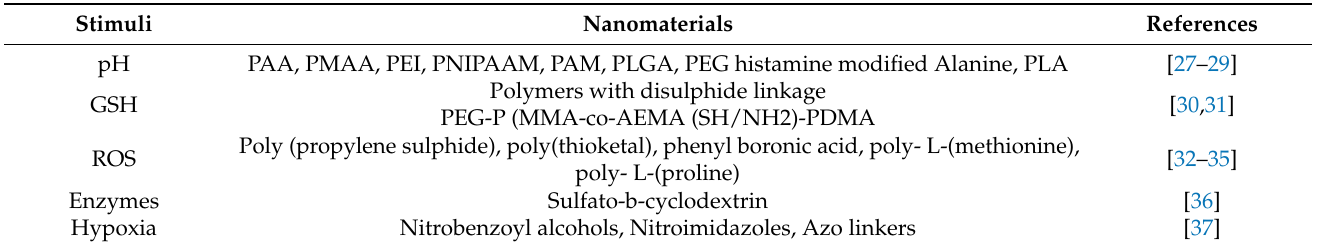
Table 1. Endogenous stimuli responsive polymeric